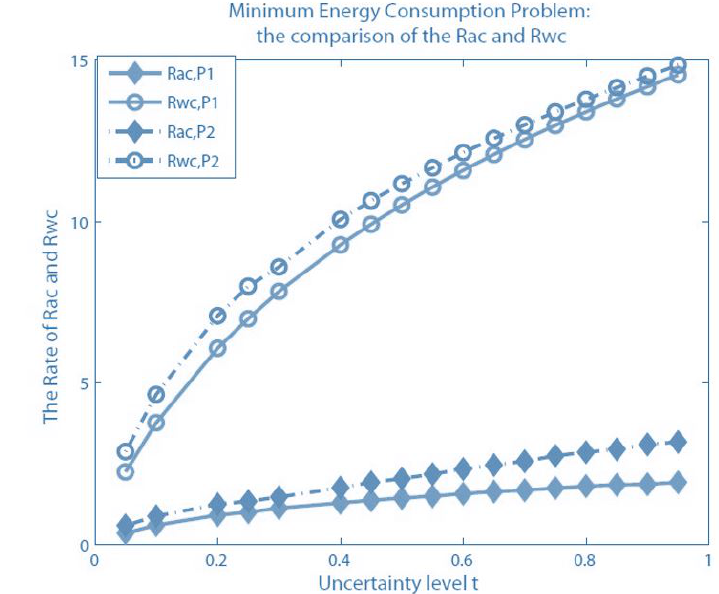
Figure 17. Ratios R ac and R wc for the minimum energy consumption problem versus the uncertainty levels